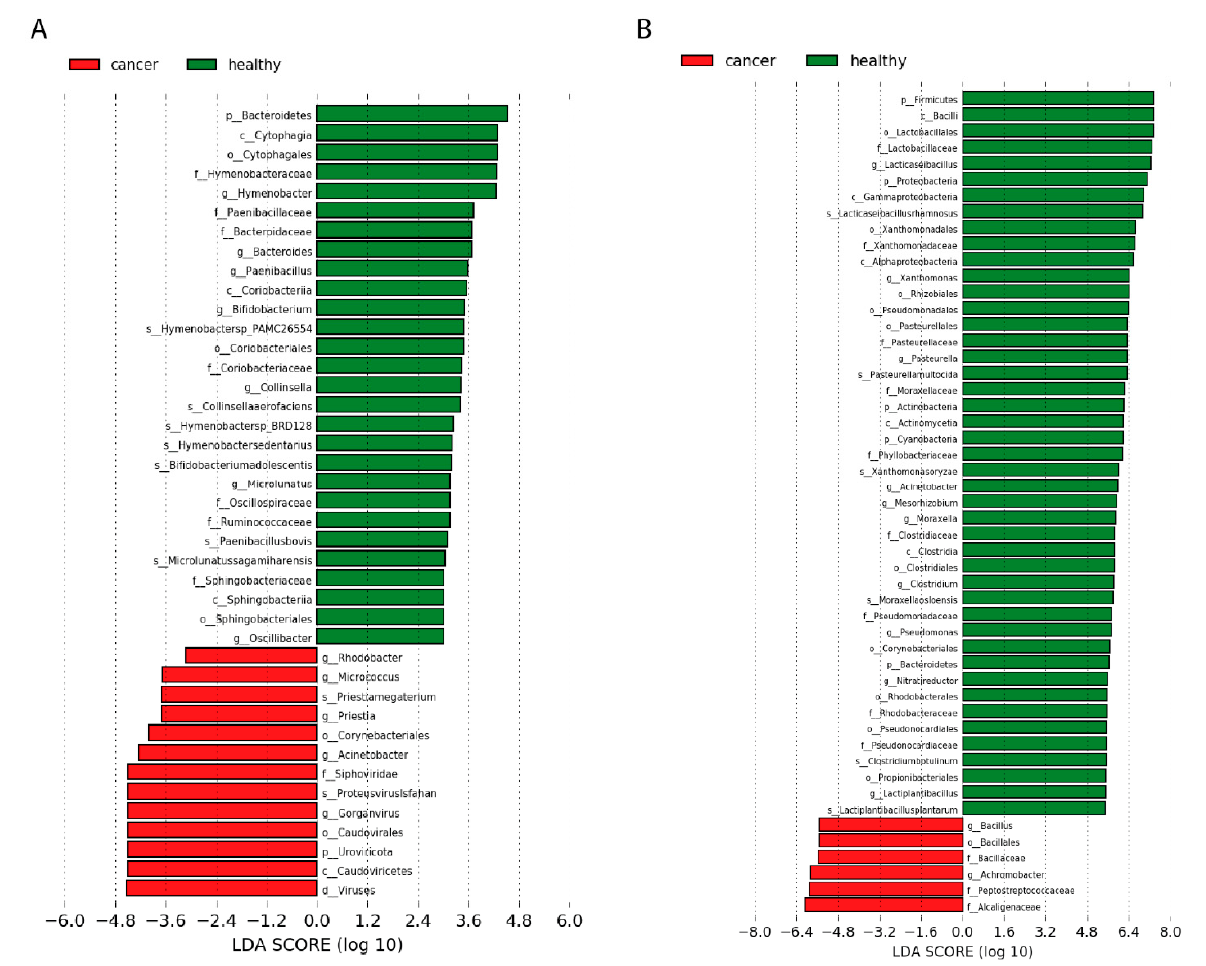
Figure 3. Differentially represented taxa (by different transcript numbers) between normal breast tissue samples (from cancer-free donors) and breast tumour tissue. Taxa on the left have a higher abundance of their transcript in primary breast tumour tissue, while those on the right have higher numbers in normal breast tissue. ( a ) Comparison of the microbiome in primary tumours of Slovak patients and normal breast tissue of Slovak cancer-free donors. Since standard conditions identified too many results, to visualise data, LEfSe was run with parameters (LDA > 3, Kruskal Wallis test p -value < 0.05, Wilcoxon test p -value < 0.05); ( b ) Comparison of microbiome in primary tumours of 72 patients from China and 18 normal breast tissues of cancer-free donors from China. For visualisation, LEfSe was run with parameters (LDA > 5.5, Kruskal Wallis test p -value < 0.05, Wilcoxon test p -value < 0.05), for the purpose of visualising the best hits. Full results of LEfSe (LDA > 2) are available on the website http://www.embnet.sk/supp/BC_metatranscriptomics/complete_plots_plotLEfSeResults/ (accessed on 19 August